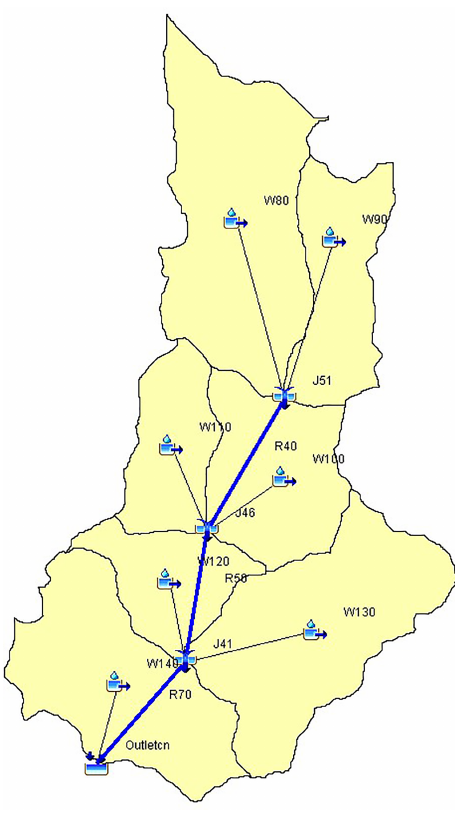
Figure 5. HEC-HMS Model Setup for Soapstone Branch Catch-